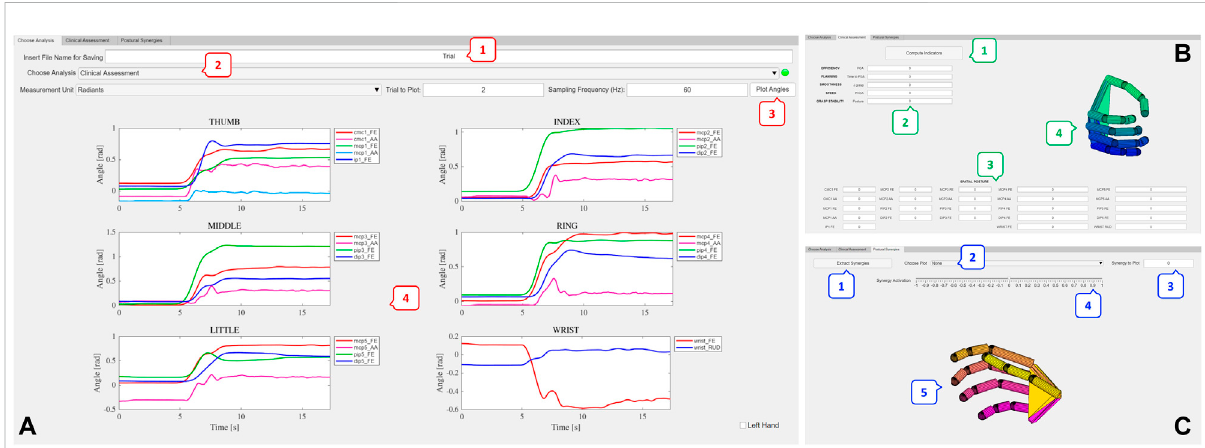
FIGURE 1 Overview of thetoolbox. (A) Initial tab ofthe tool, which allows inserting thename ofthe MATLAB struct that will be saved (1).From the Choose Analysis dropdown menu (2) it is possible to choose the analysis to perform between Clinical Assessment and Postural Synergies extraction. Joint anglesareautomaticallycomputedandtheusercanselecttheunitofmeasurementtovisualizethejointangles,choosethetrialtoplotandinsertthe sampling frequency of data. Then, by pressing the Plot Angles button (3), angles can be inspected (4). (B) The Clinical Assessment tab allows computing the performance indicators that quantify movement quality (1,2) and the spatial posture of the hand (3), i.e., the range of motion. The customized virtual hand model reproducing the trial static hand posture can be visualized and saved (4). (C) The Postural Synergies tab allows automatically extracting postural synergies by pressing the Extract Synergies button (1). Meaningful plots (Pareto, Scree Plot, Loadings Plot) can